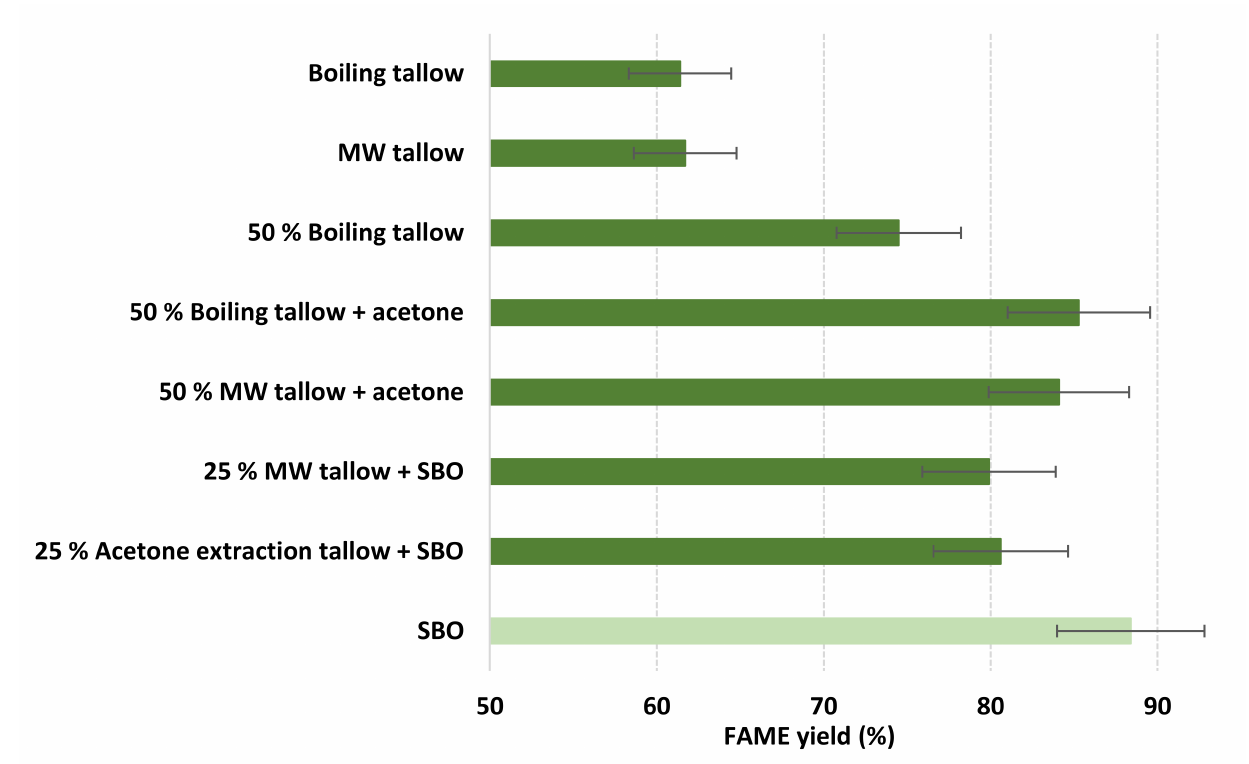
Figure 8. FAME yield obtained by methanolysis of the extracted fats at reflux temperature (methanol/oil = 12 molar ratio; W cat /W oil = 5%; 2.5 h reaction time). The methanolysis of soy- bean oil (SBO) was used as a standard.